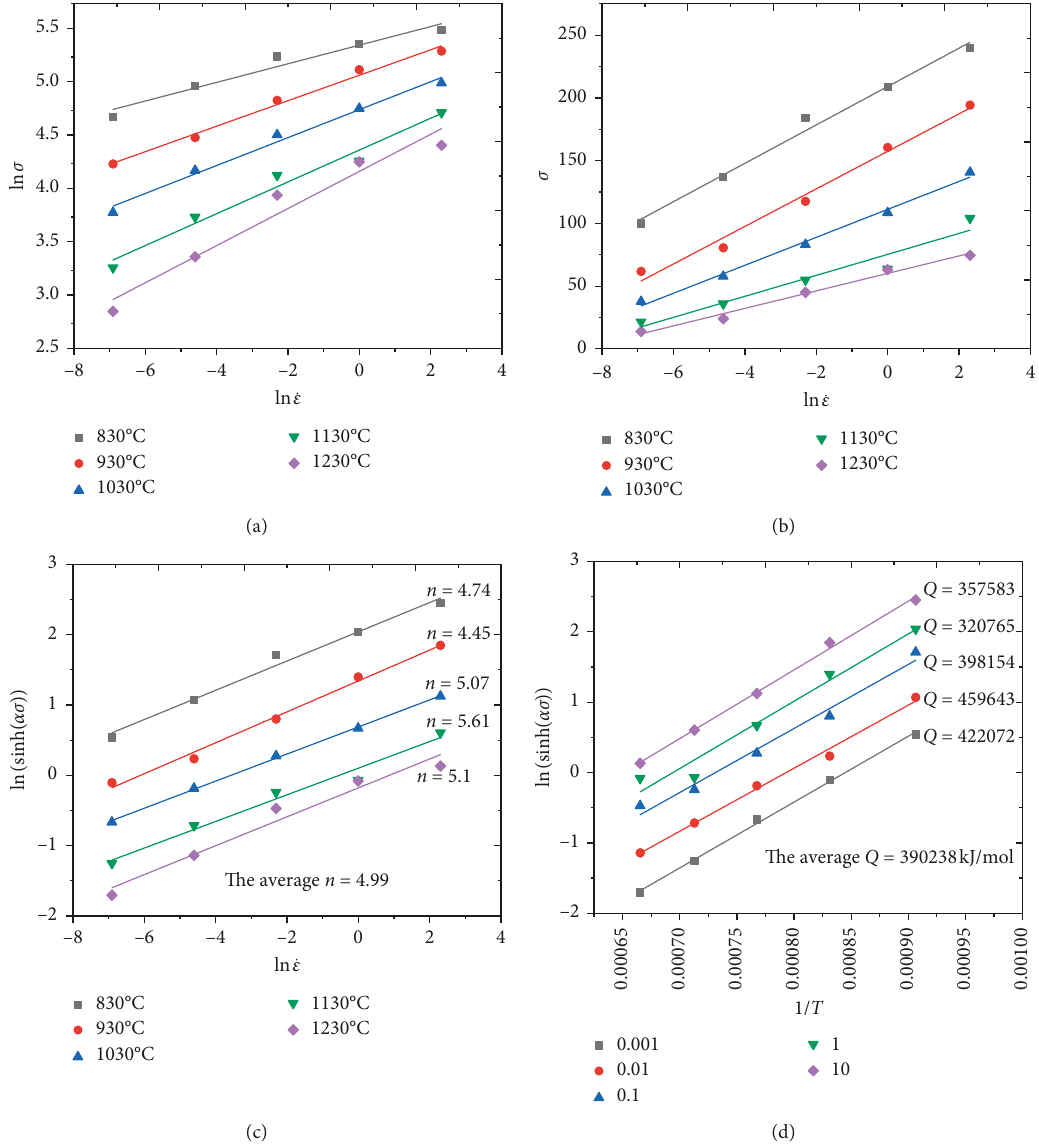
Figure 3: Relationships between (a) ln _ ε and ln σ , (b) ln _ ε and σ , (c) ln _ ε and ln ( sinh ( ασ )) , and (d) ln ( sinh ( ασ )) and 1/ T